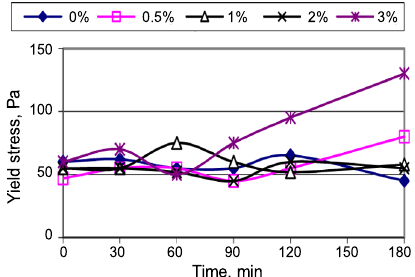
Fig. 12. Cement paste with CEM II R cement yield point